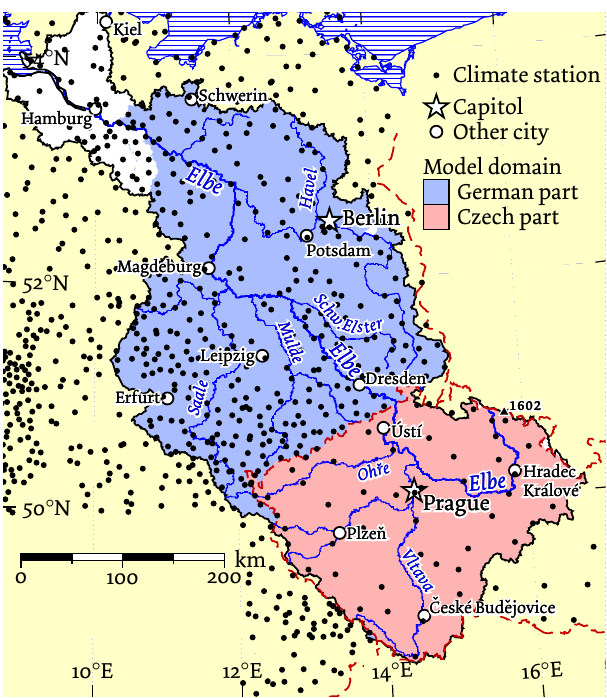
Fig. 3. The model domain and the locations of climate